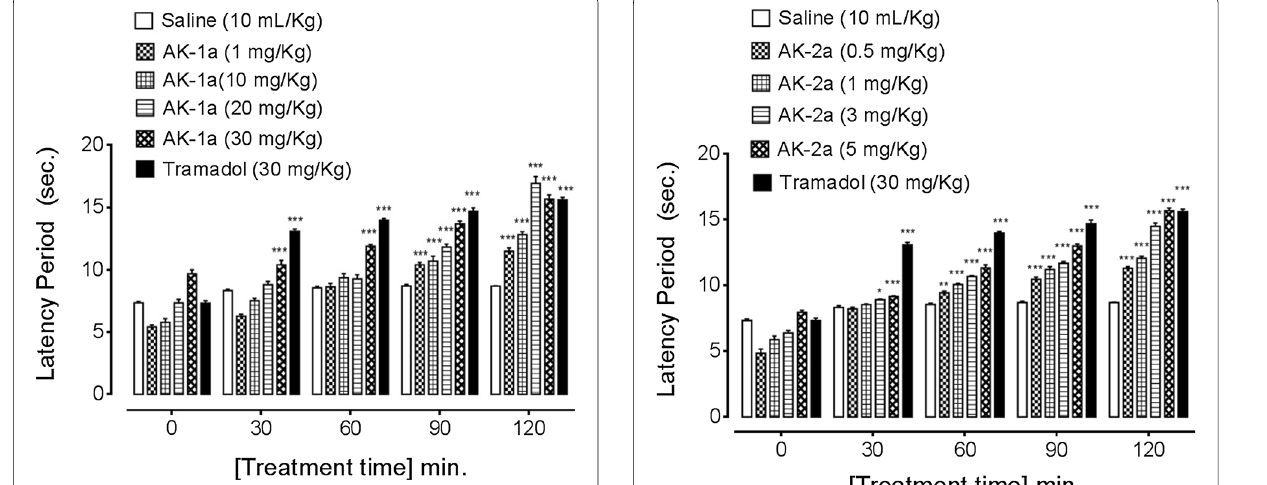
Fig. 14 Effect of (2 E ,5 E )‑2‑(4‑methoxybenzylidene)‑5‑(4‑nitrobenz Fig. 15 Effect of (1 E ,4 E )‑4‑(4‑nitrobenzylidene)‑1‑(4‑nitrophenyl) ylidene) cyclopentanone (AK‑1a) and tramadol on latency time in oct‑1‑en‑3‑one (AK‑2a) and tramadol on latency time in hot plate hot plate assay. Data expressed as mean SEM, n 5. *** P < 0.001 vs. ± = assay. Data expressed as mean saline group, one way ANOVA with post hoc Tukey’s test *** P < 0.001 vs. saline group, one way ANOVA with post hoc Tukey’s value of 65.2 µM. At same concentrations AK-2a inhib- ited AA-induced platelet aggregation to 4.3 0.07, ± 10.5 0.09, 28 0.15, 42.7 0.22, 62.2 0.08, 78.9 0.19 Fig. 16. At 440 µM concentration, heparin increased ± ± ± ± ± and 89.8 0.13% respectively with IC 50 value of 37.7 µM. coagulation time to 379.40 ± Aspirin inhibited AA-induced platelet aggregation to group). 27.2 0.18, 36 0.09, 50.1 0.16, 59.7 0.09 and 100% ± ± ± ± respectively with IC 50 value of 10.01 µM, as shown in